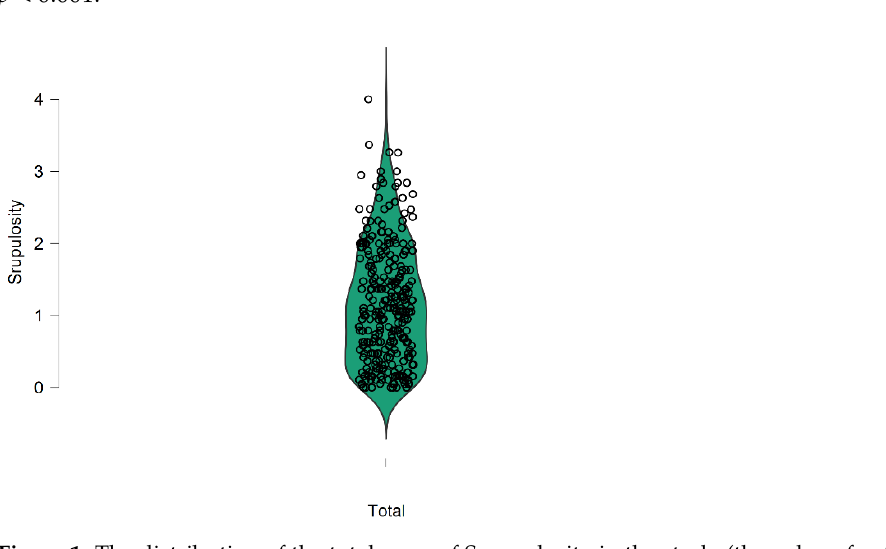
Figure 1. The distribution of the total score of Scrupulosity in the study (the value of cut-off level 1.42 is represented by the 64 percentile).